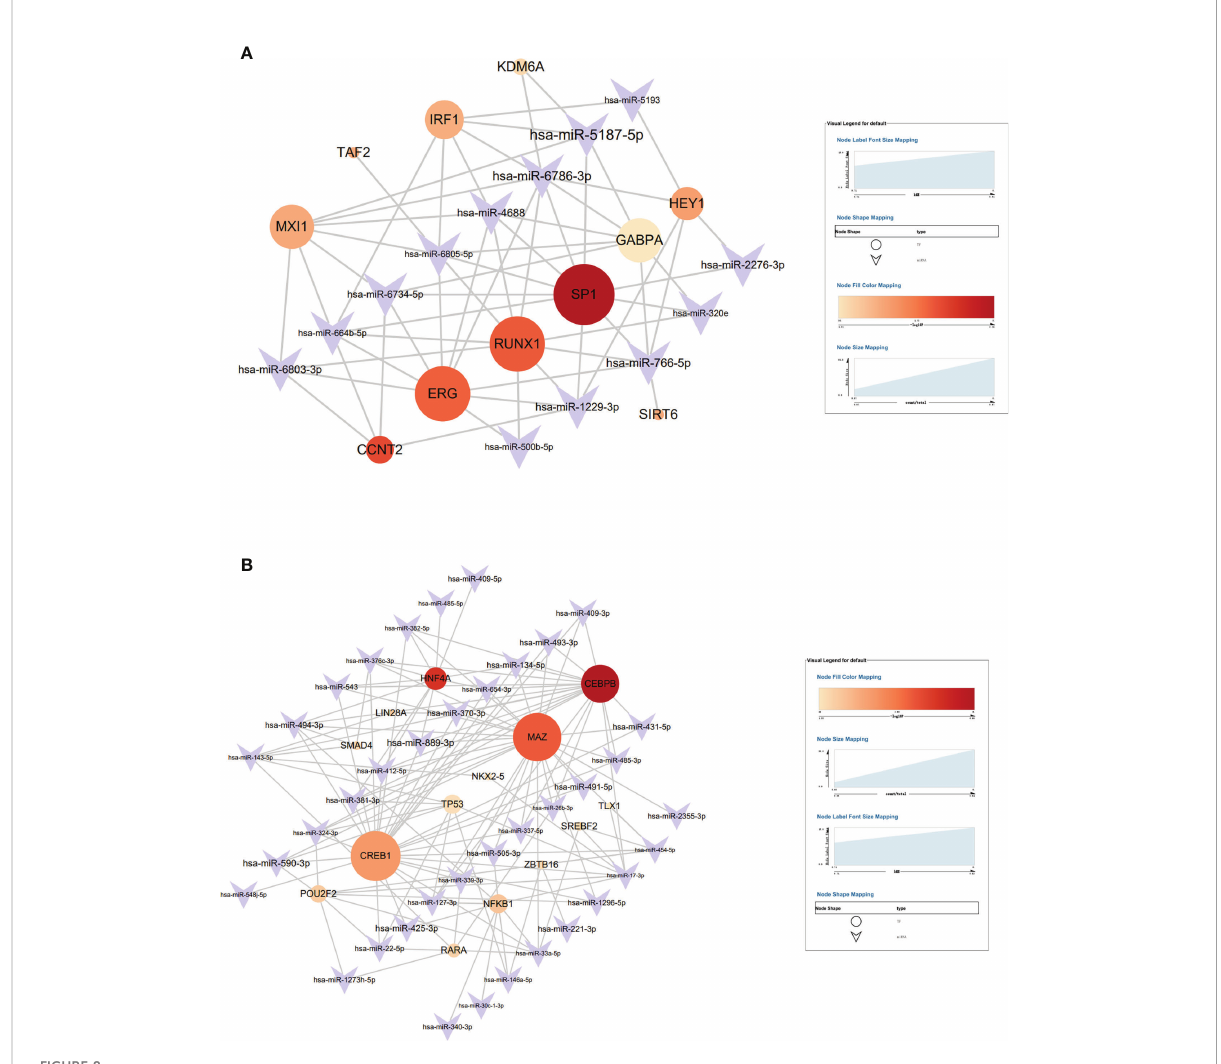
FIGURE 8 The target interaction regulatory network diagram of transcriptional factors (TF) and miRNAs of the brown module (A) and blue module (B)